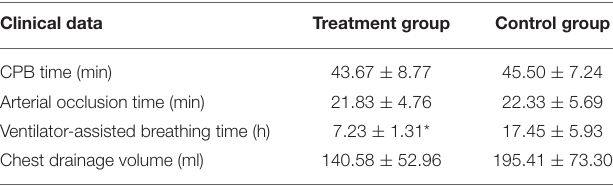
TABLE 2 | Comparison of intraoperative and postoperative clinical data between the two groups ( x ± s, n = 15). Clinical